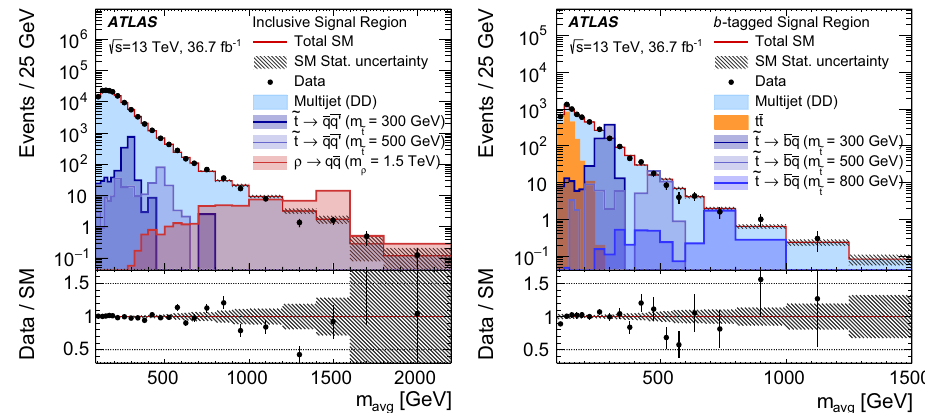
orange. The statistical uncertainties of the prediction are shown by the grey hatched band. Signals of different masses are overlaid in different